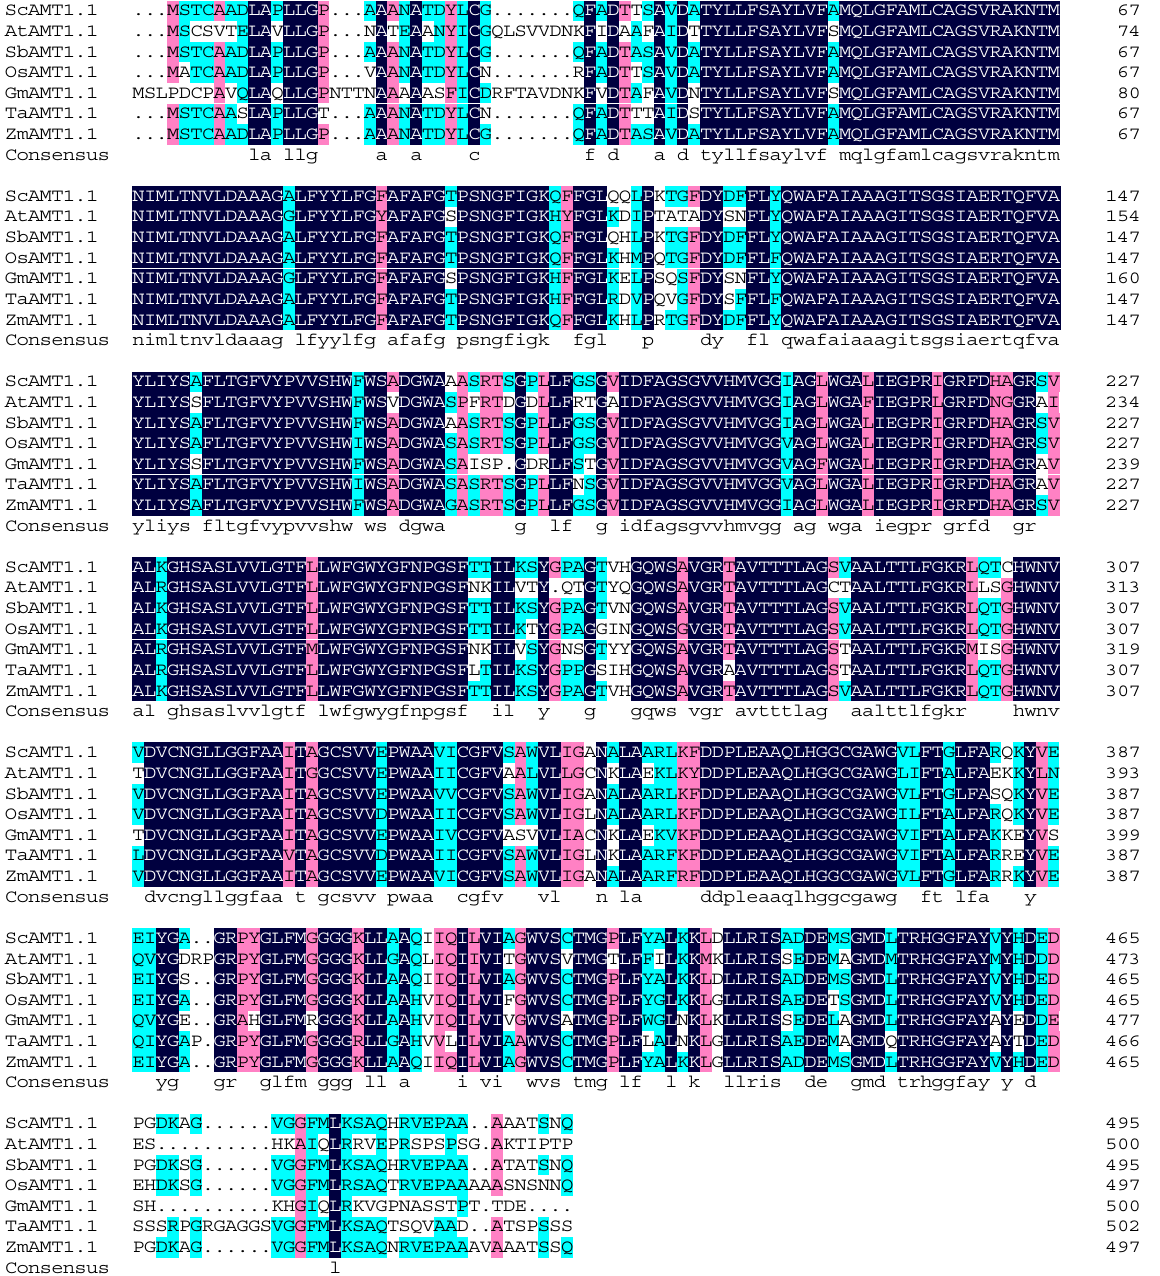
Figure 4. Sequence alignment of ScAMT1.1 and AMT1.1s from other species. Notes: S. bicolor (SbAMT1.1, AGK25010.1), Z. mays (ZmAMT1.1, NP_001140828.1), O. sativa (OsAMT1.1, Q7XQ12.1), T.aestivum (TaAMT1.1, AAS19466.2), G. max (GmAMT1.1, XP_003555734.1), and A. thaliana (AtAMT1.1, EFH51425.1).